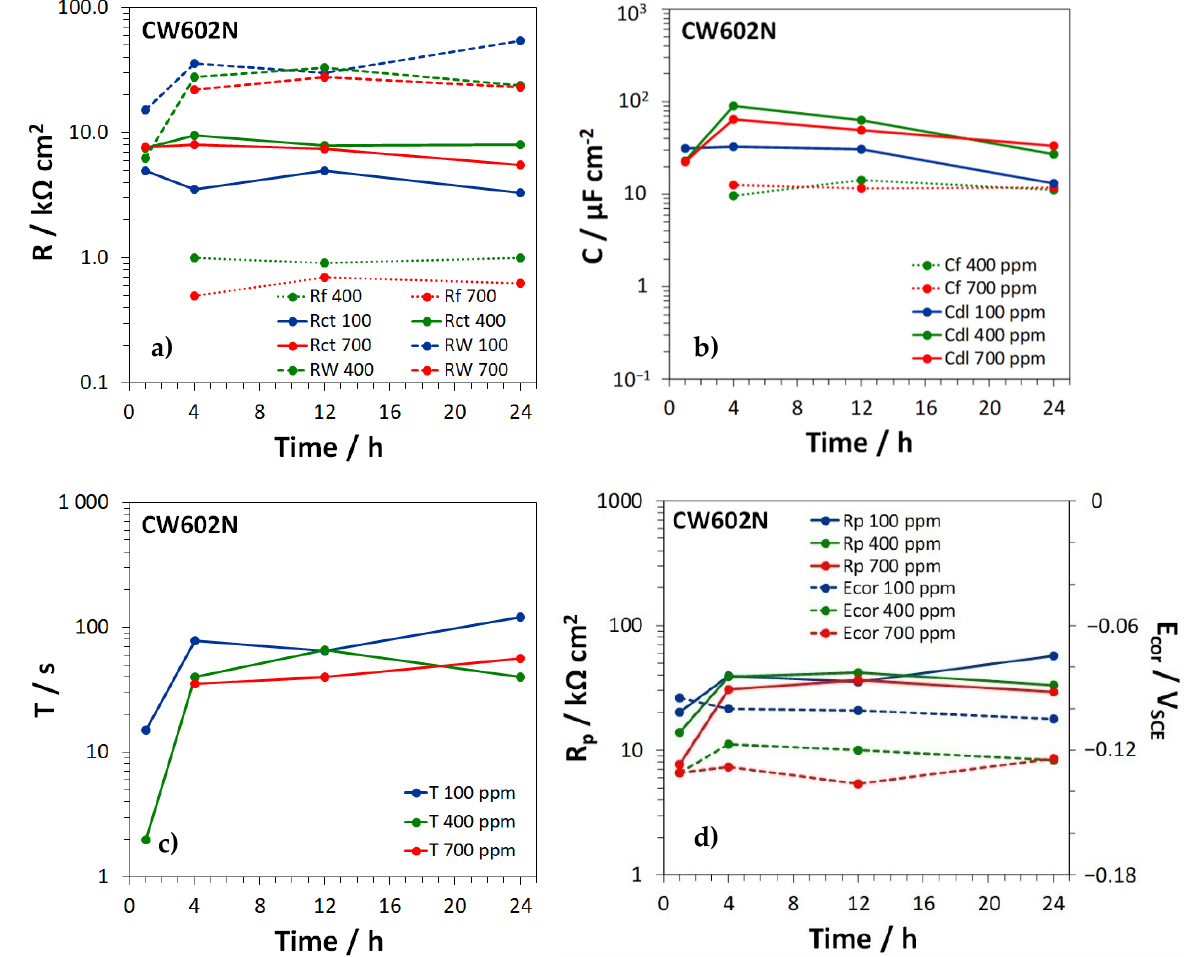
Figure 9. Time dependence of ( a ) the film, charge transfer, and diffusion resistances, ( R f , R ct , and R w ); ( b ) the film and double layer capacitances ( C f and C dl ); ( c ) the T parameter of the GFLW element; and ( d ) the polarization resistances ( R p ) and the corrosion potentials (E cor ), measured on CW 602N during the immersion in SDW with three different chloride